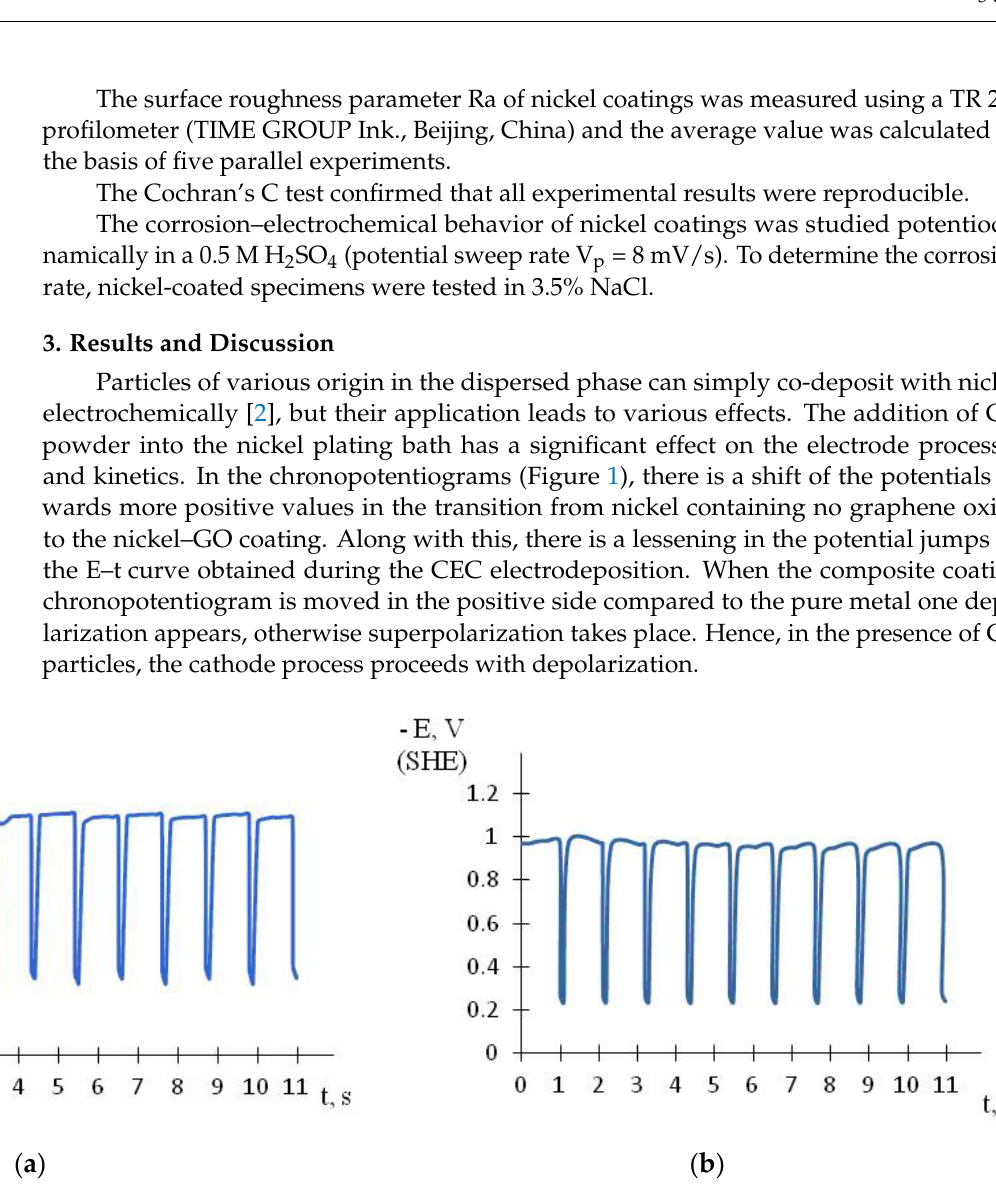
Figure 1. E–t curves of Ni ( a ) and Ni–GO CEC ( b ) electrodeposition (cathode current density 10 A/dm 2 ).